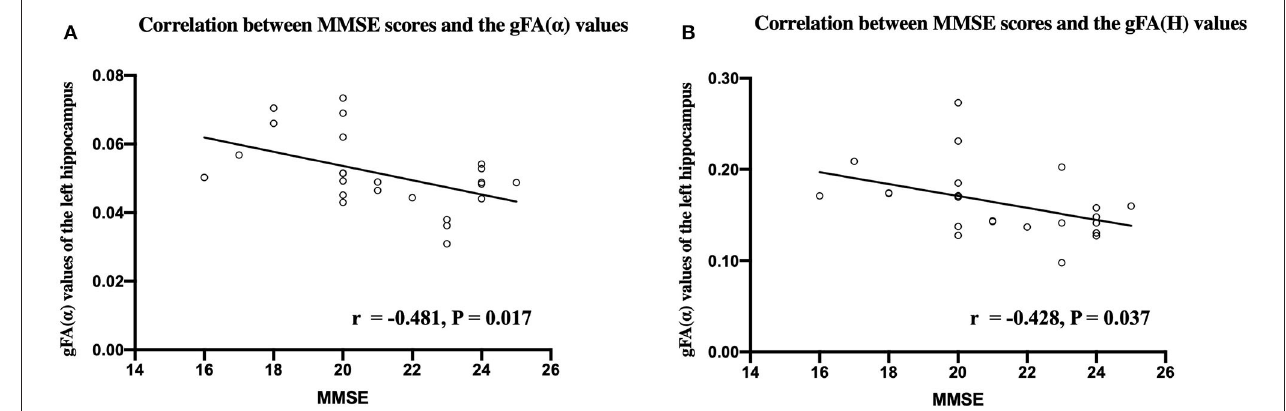
FIGURE 9 | Correlations between MMSE scores and the gFA( α ) (A) and gFA( H ) (B) values of the left hippocampus in patients with AD. Pearson correlation was conducted. n = 24. MMSE, mini-mental state examination; gFA, generalized fractional anisotropy; AD, Alzheimer’s disease.